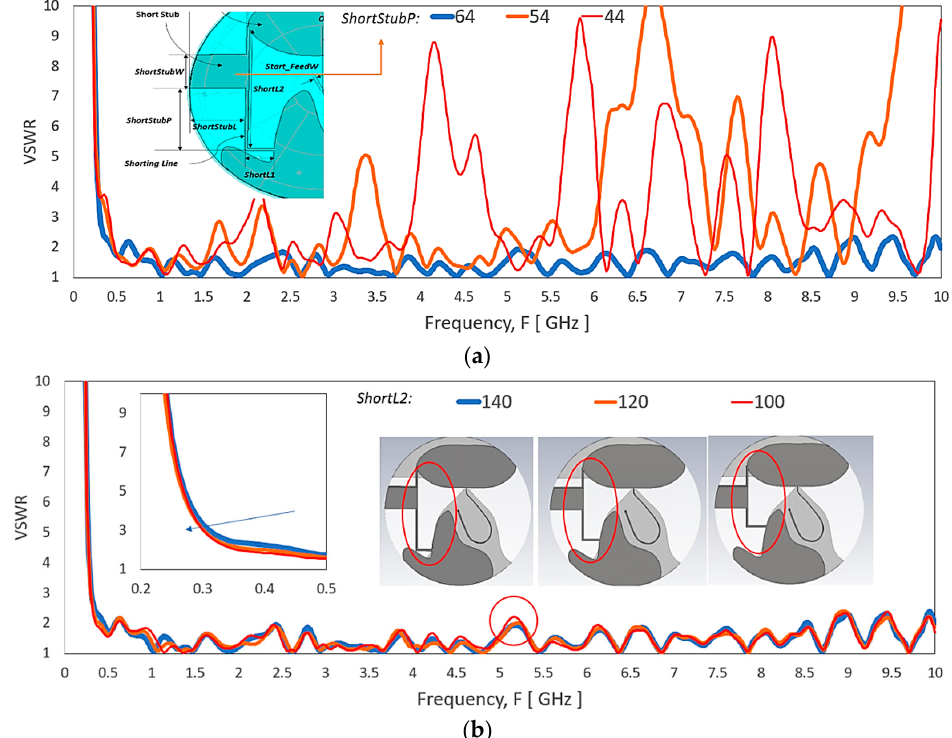
Figure 21. VSWR of the antenna by varying the ( a ) stub location, ShortStubP at the shorting between the monopole patch and the proximity ground coupling patch, and ( b ) shorting path length, ShortL2 .